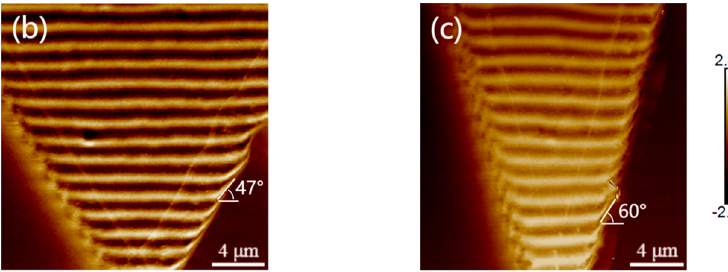
Figure 3. Stripe magnetic domain structure of triangular pa tt ern CoFeB with di ff erent top angles φ : ( a ) 90°, ( b ) 60°, ( c ) 30°.